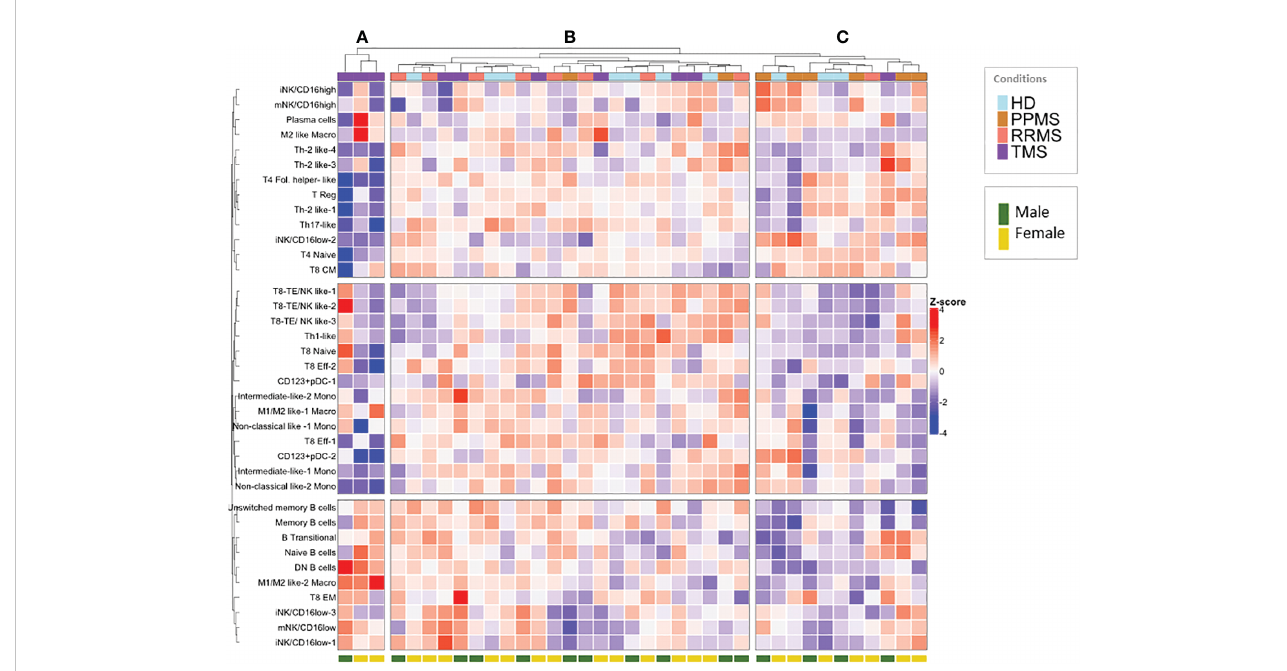
FIGURE 7 Hierarchical clustering of normalized peripheral blood immune subset frequencies in HD and MS patients. Hierarchical clustering (A – C) of normalized immune subset frequencies (% of total CD45+ cells) in peripheral mononuclear cells from all patients (n=27; PPMS=8, RRMS=9, TMS=10) and healthy donors (HD; n=10). Gender (male, female) from healthy donors and patients is also indicated in the lower part of the heatmap.